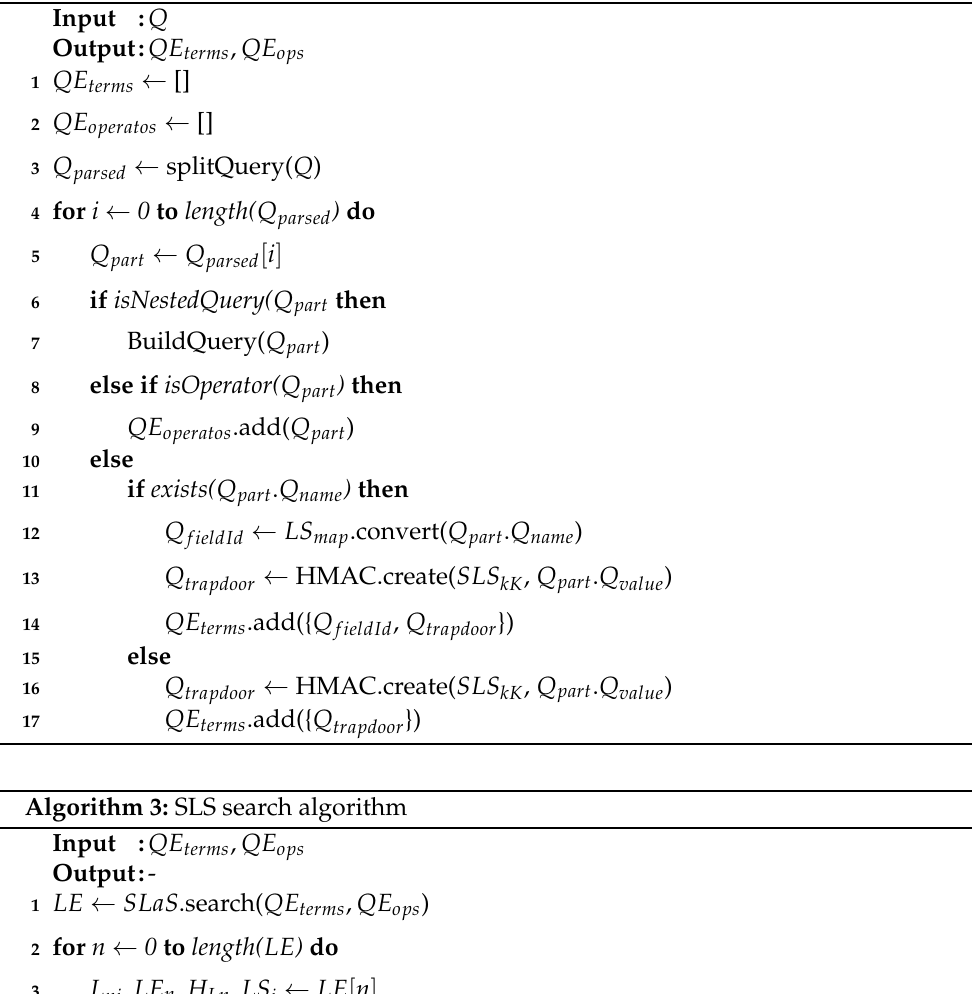
Algorithm 2: SLS query builder algorithm